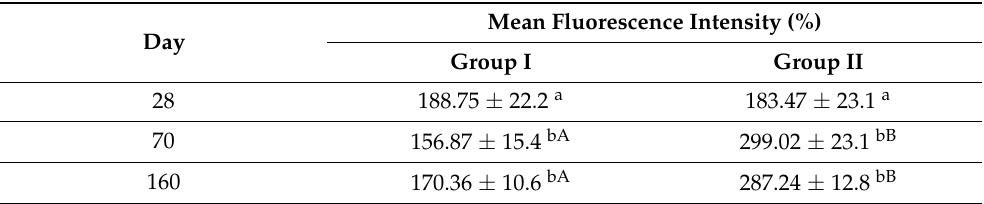
Table 3. Mean fluorescence intensity of peripheral blood phagocytic cells in pigs from groups I and II. Values are expressed as mean and standard deviation ( α +/ − SD).